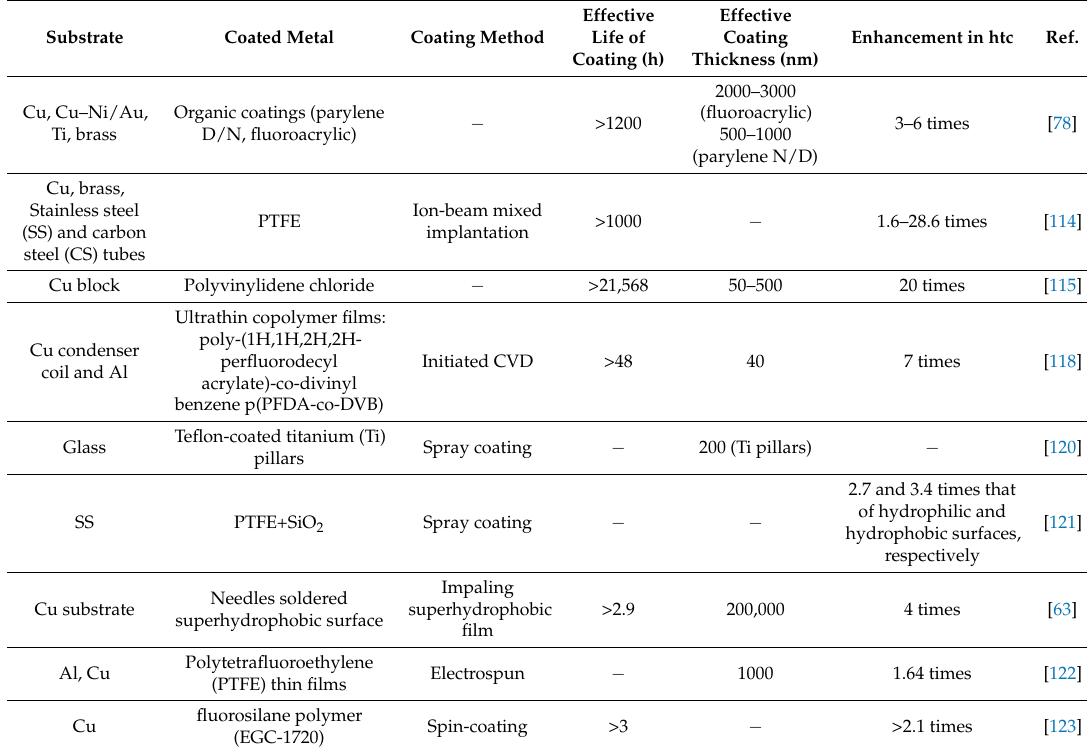
Table 3. Steam condensation enhancements by polymer